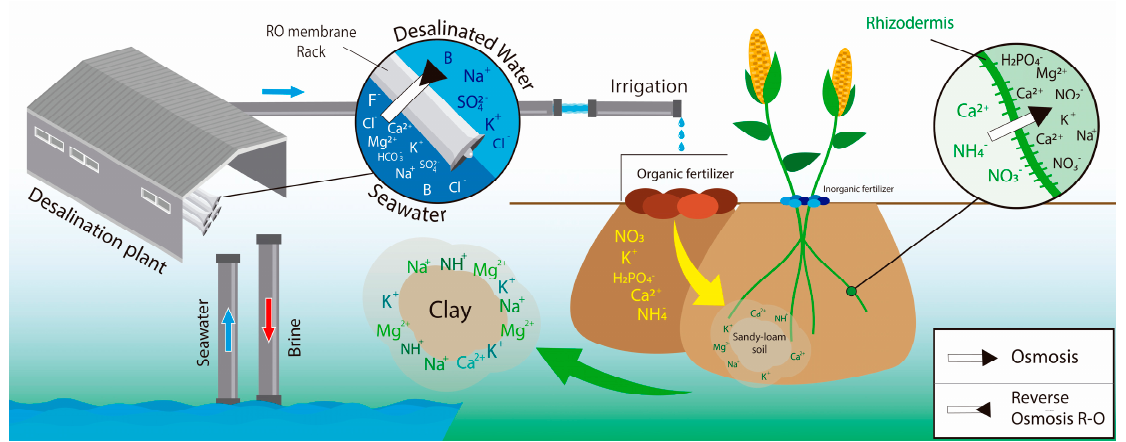
Figure 4. Graphical description of the key elements’ absorption supplied for a desalinated seawater. Source: Own elaboration.